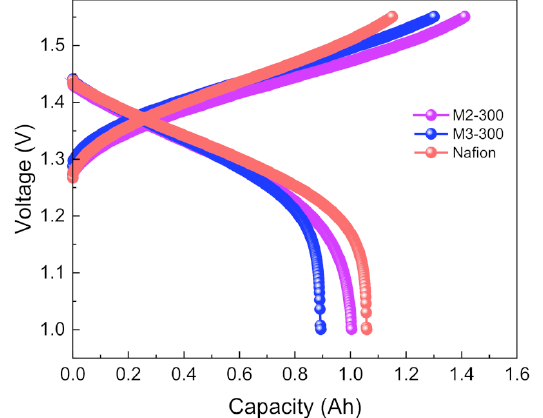
Figure 4. The charge–discharge curves of VFBs with M2-300, M3-300, and Nafion